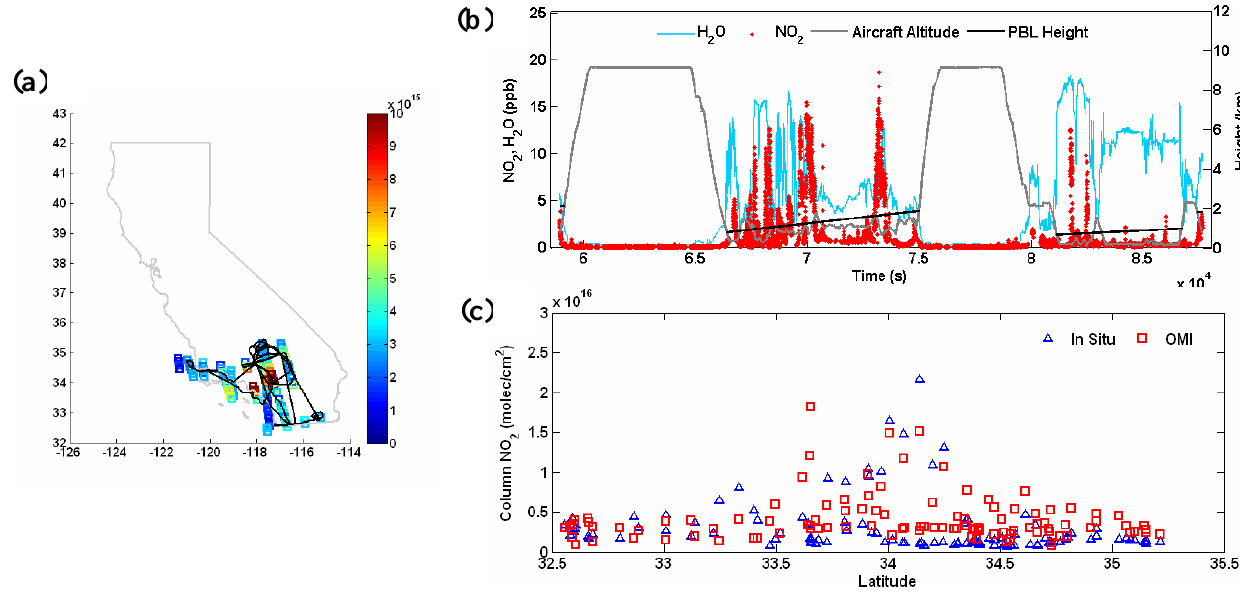
Fig. 5. (a) The black line shows the flight path over CA of the DC-8 aircraft on 24 June 2008. Colored squares show the column concentration and location of the center of coincident OMI pixels. (b) Aircraft altitude, H 2 O vapor concentration, NO 2 concentration, and inferred boundary layer height versus time for the flight on 24 June. (c) In situ derived and OMI Standard Product columns collected on 24